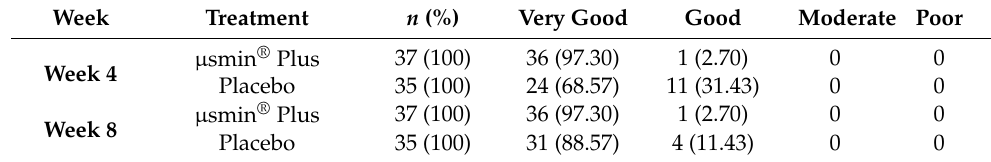
Table 5. Investigator Global Assessment of Safety (IGAS) after 4 weeks and 8 weeks of